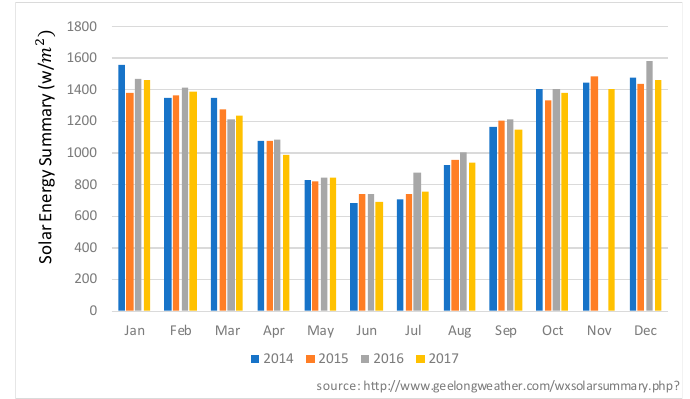
Figure 11. Distribution of solar energy generation during the period of observation.